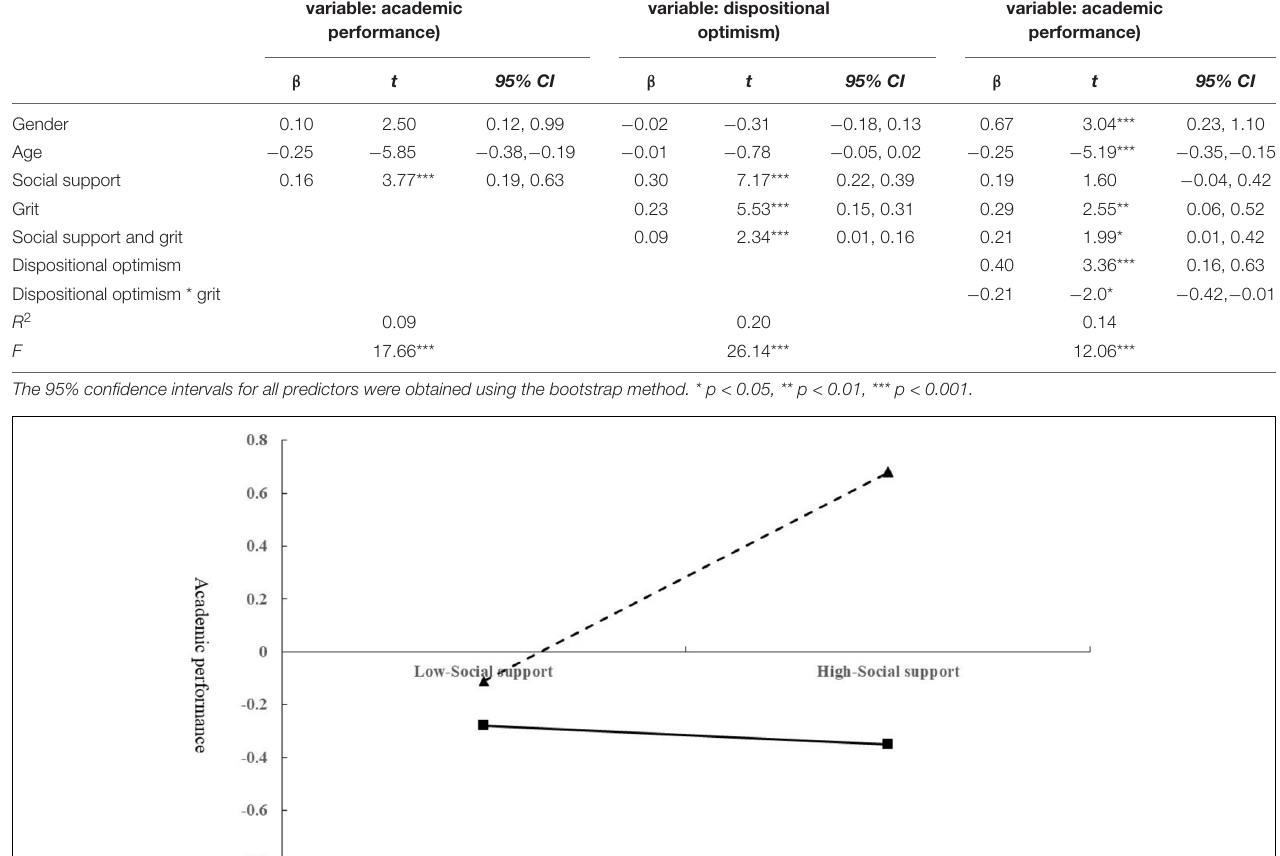
Equation 3 (dependent variable: academic